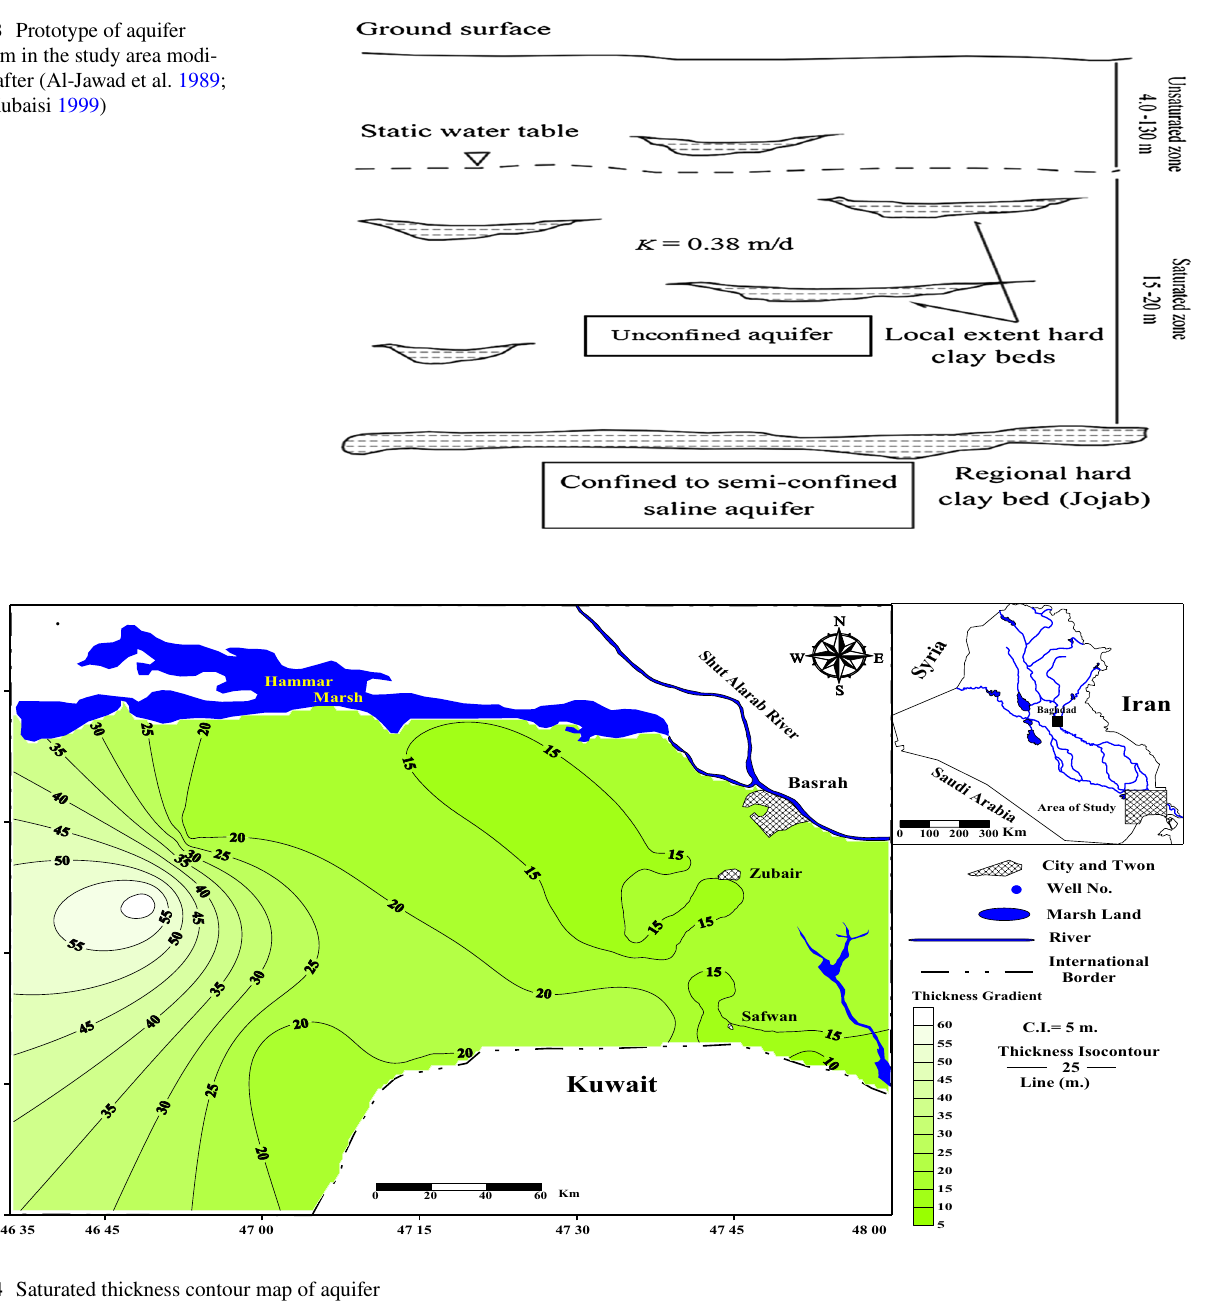
Fig. 4 Saturated thickness contour map of